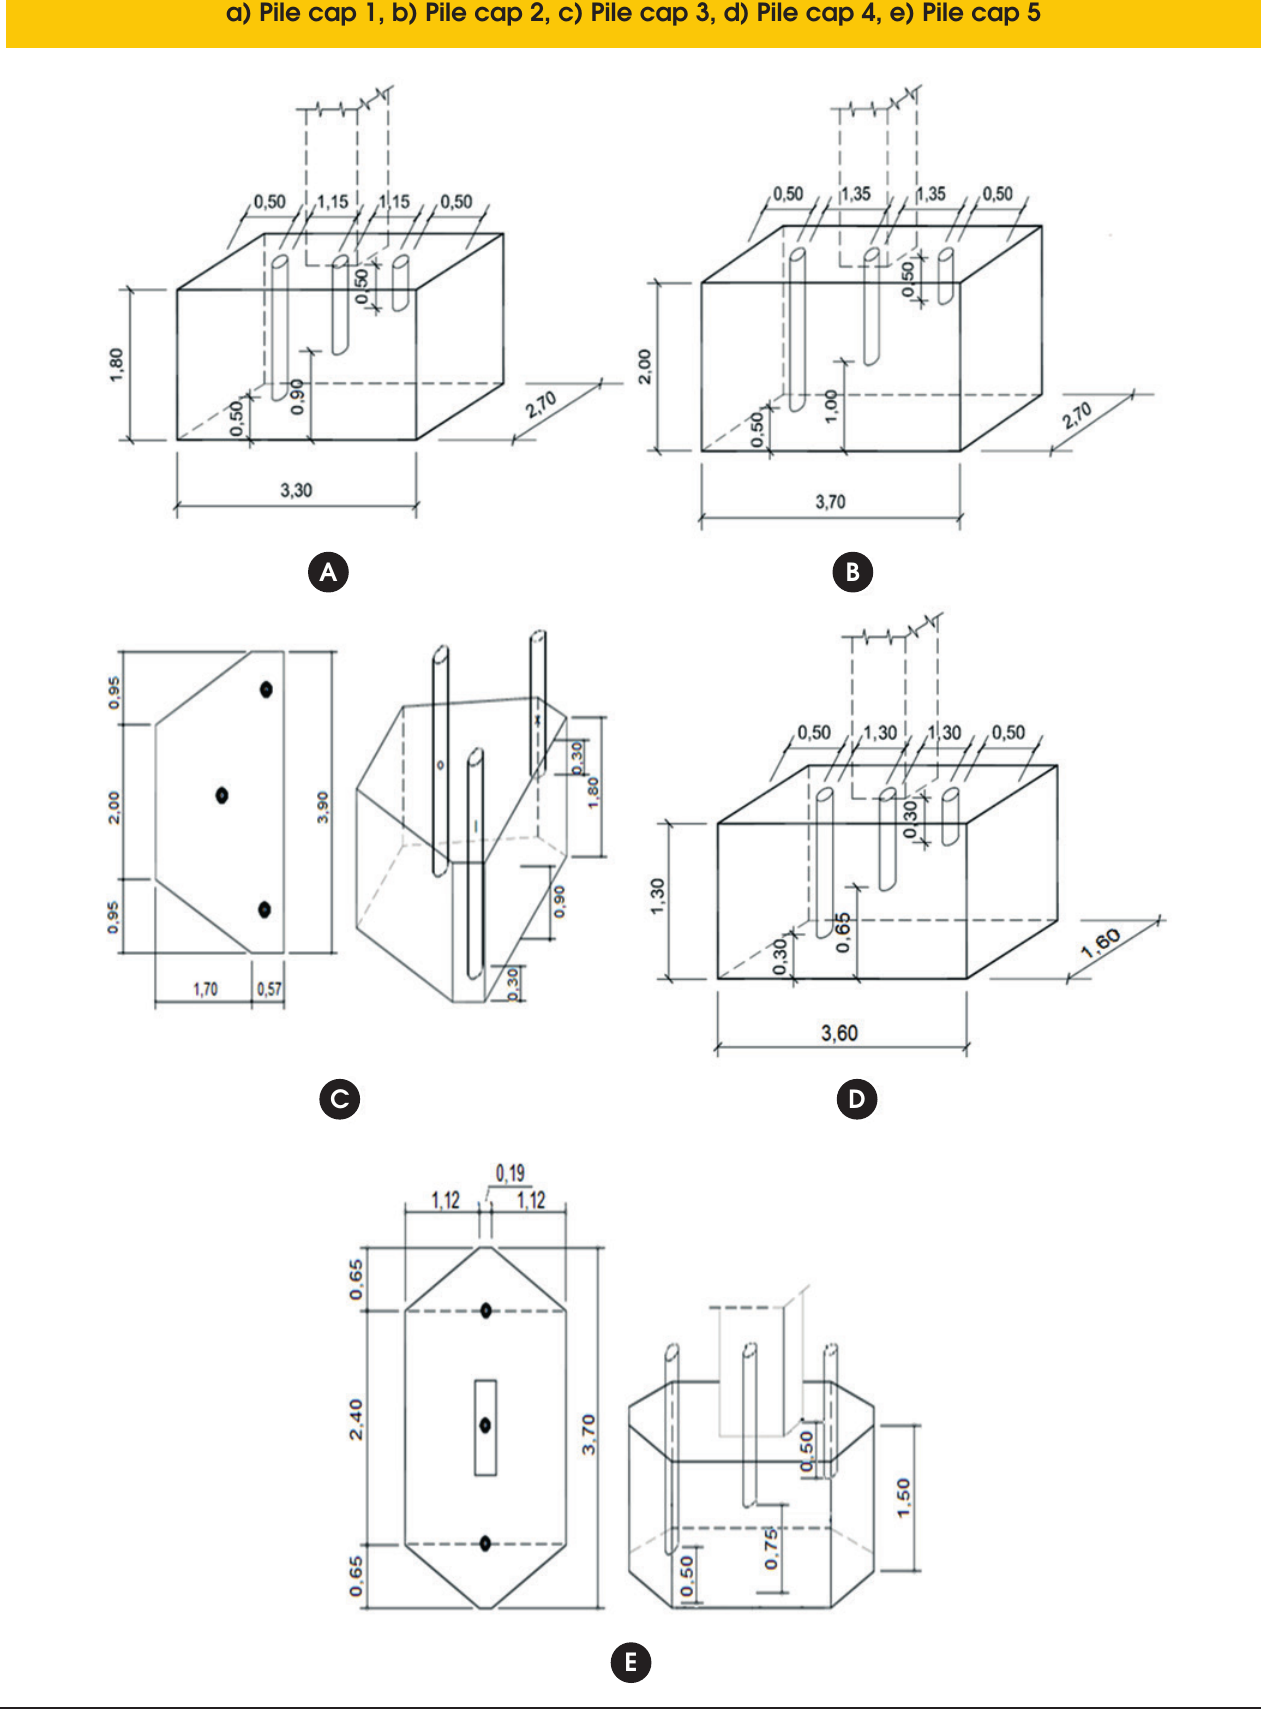
Figure 3 – Geometric details of the pile caps and allocation of the